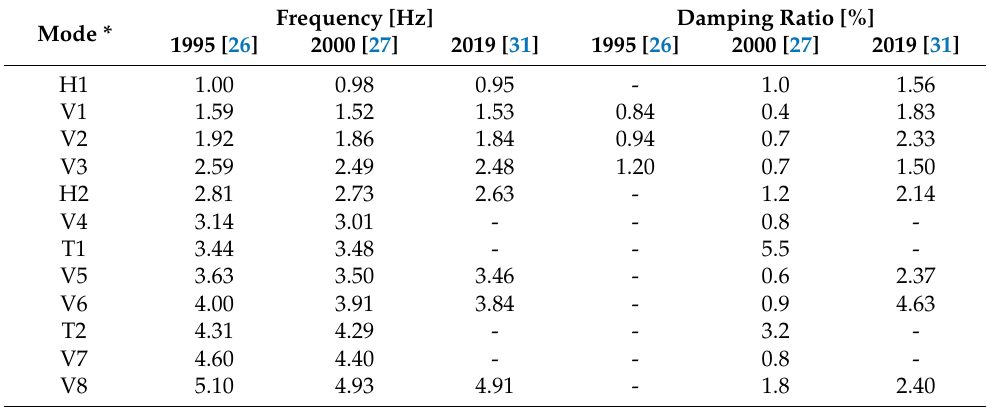
Table 1. Monitoring activities: the frequencies and related damping ratios. Mode